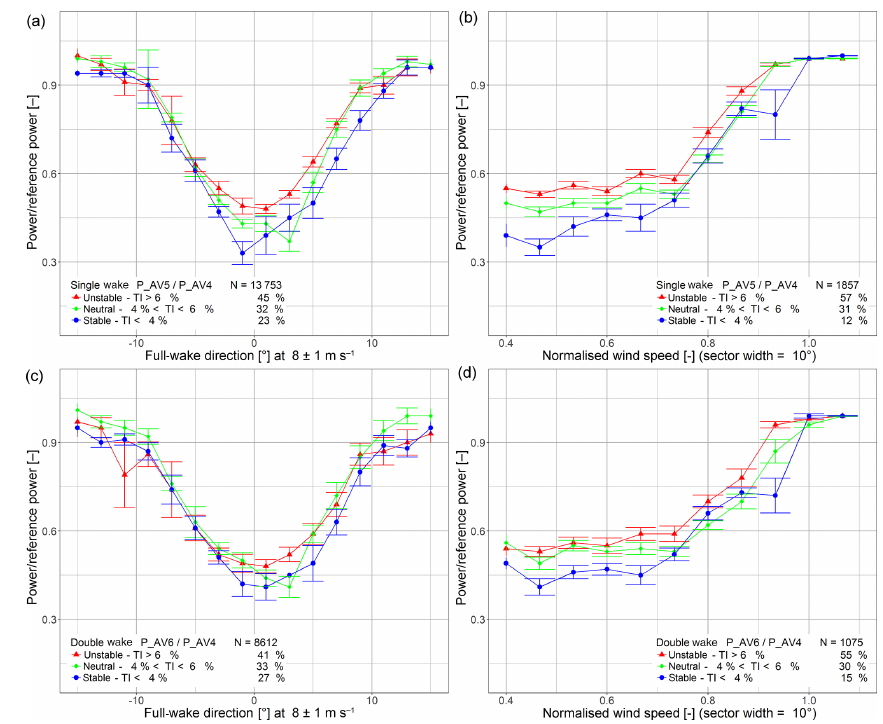
Figure 8. Wake effects in alpha ventus (AV) under different atmospheric conditions classified by met mast turbulence intensity. Power of downstream turbine normalised with free-flow turbine. Upper row: single wake, bottom row: double wake. Left column: normalised power as a function of wind direction, right column: normalised power as a function of wind